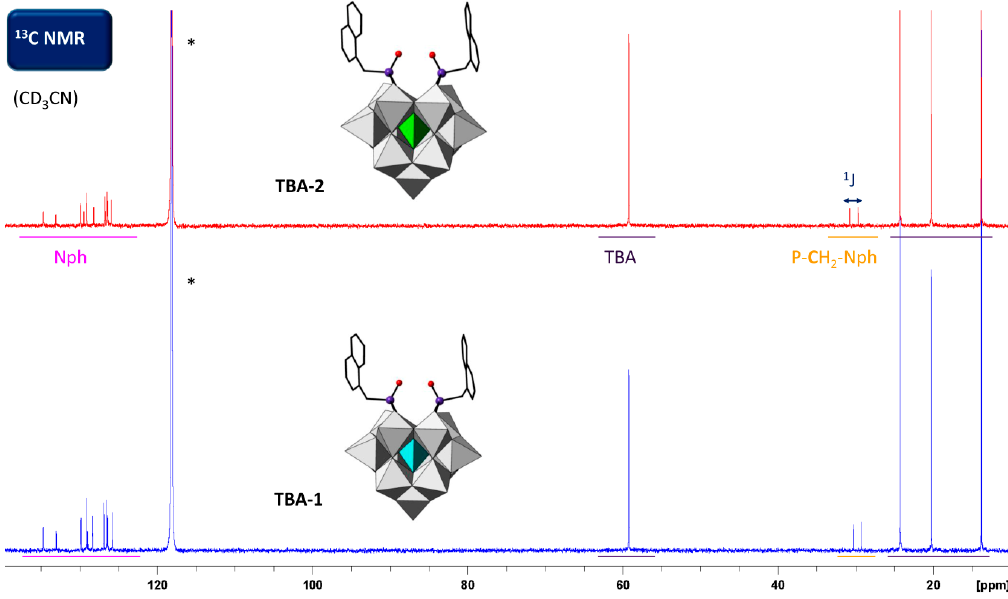
Figure 11. 13 C-NMR spectra of TBA-1 and TBA-2 in CD 3 CN. The signals labeled as * correspond to the solvent.